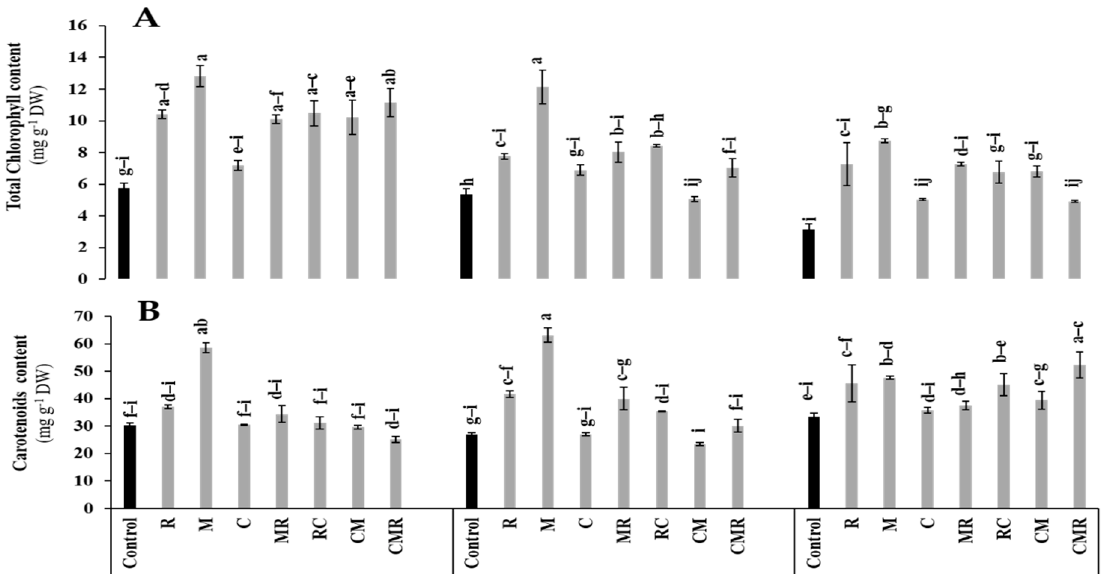
Figure 5. Impact of salt stress (0, 50, and 100 mM NaCl) on ( A ) Total chlorophyll content and ( B ) carotenoids content in lettuce subjected to different biostimulant treatments; control plants (non–amended, non–inoculated), and plants inoculated with plant growth promoting rhizobacteria (R) and/or arbuscular mycorrhizal fungi (M), and/or amended with composts (C). Means (± SE of 5 biological replicates) followed by the same letters are not significantly different at p < 0.05 (Tukey’s HSD).